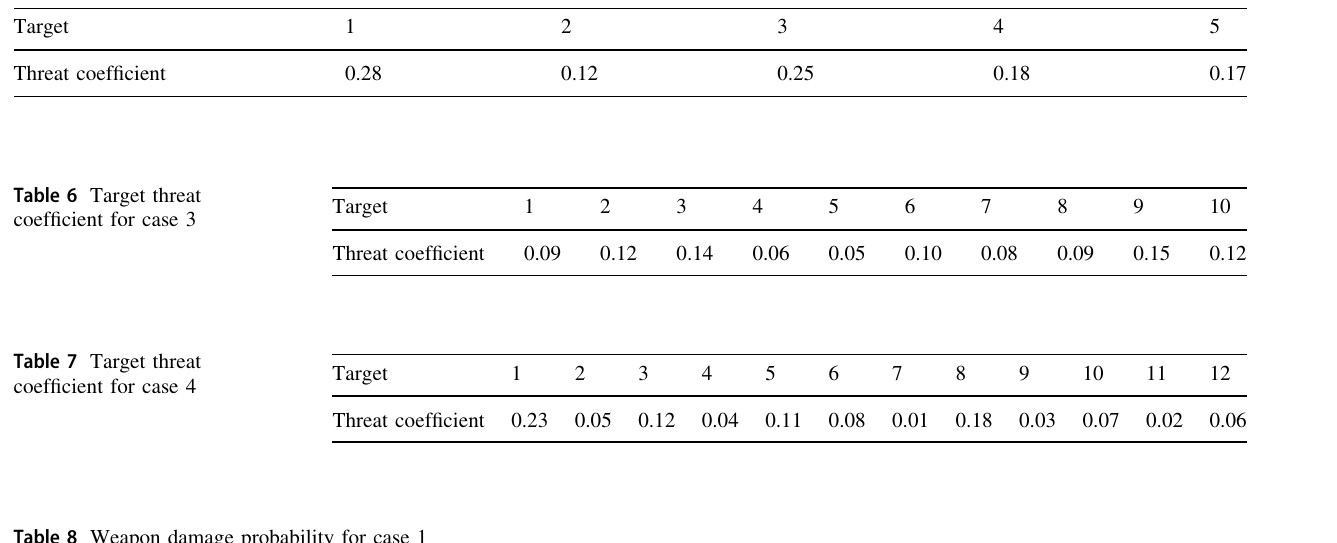
Table 8 Weapon damage probability for case 1 Weapon system